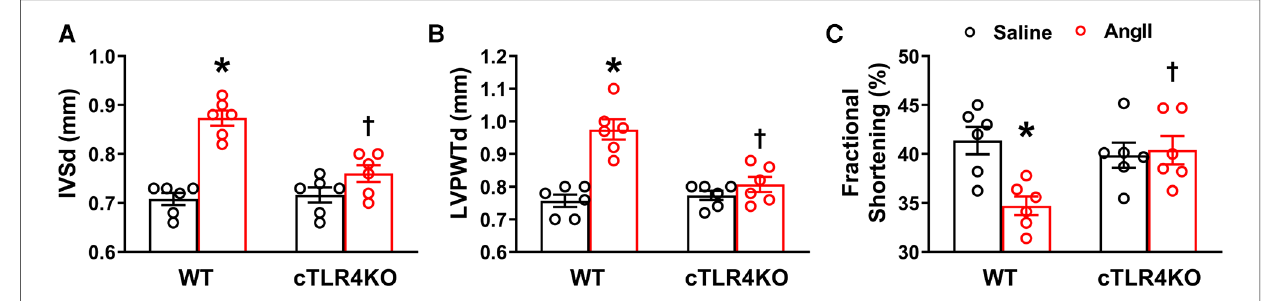
FIGURE 5 Cardiomyocyte-speci fi c TLR4 deletion attenuates angiotensin II-induced cardiac dysfunction. Echocardiography was used to evaluate cardiac function following Ang II infusion in hypertensive mice. In WT mice, Ang II signi fi cantly increased ( A ) interventricular septal thickness end diastole (IVSd) and ( B ) left ventricular posterior wall thickness end diastole (LVPWTd), while decreasing ( C ) fractional shortening %. However, these changes were reversed in cTLR4KO mice with Ang II infusion. ( n =6 mice/group, two-way ANOVA, * p <0.05 vs. WT+Saline, † p <0.05 vs. WT+Ang II).